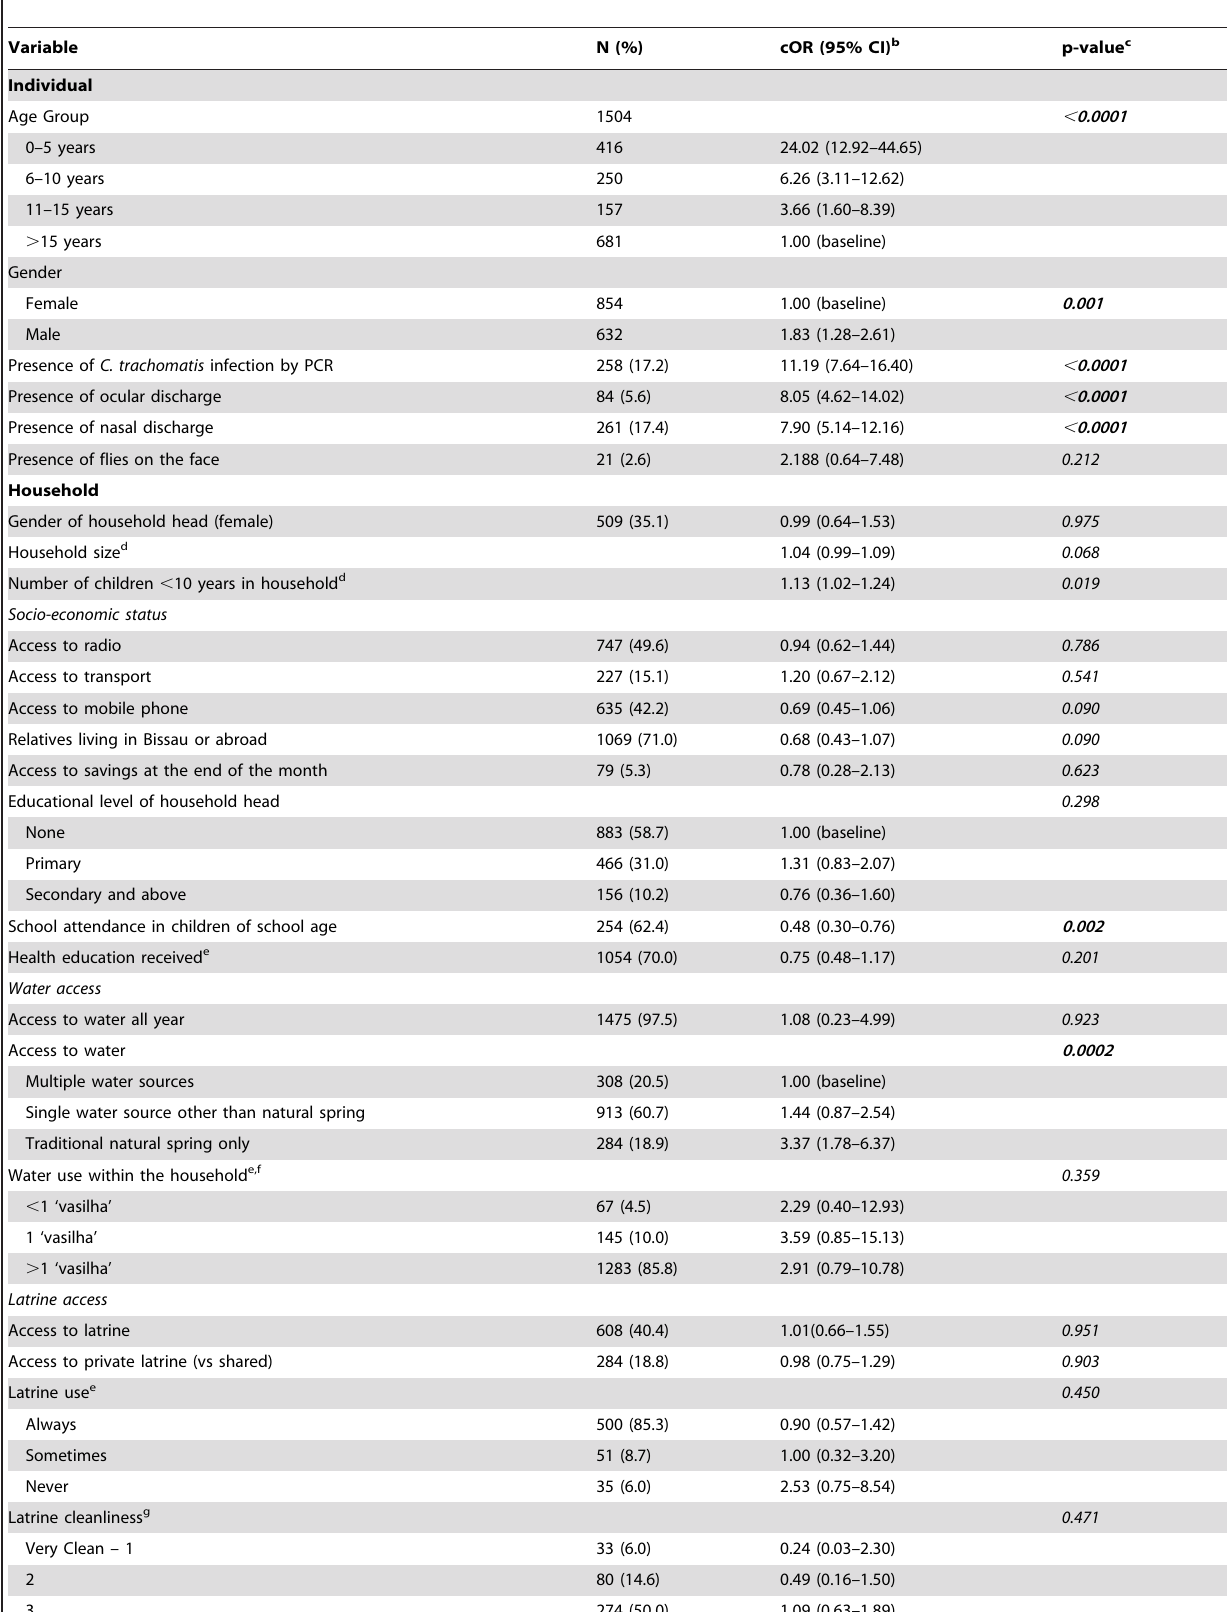
Table 3. Multilevel univariable random effects logistic regression analysis of factors associated with active trachoma a